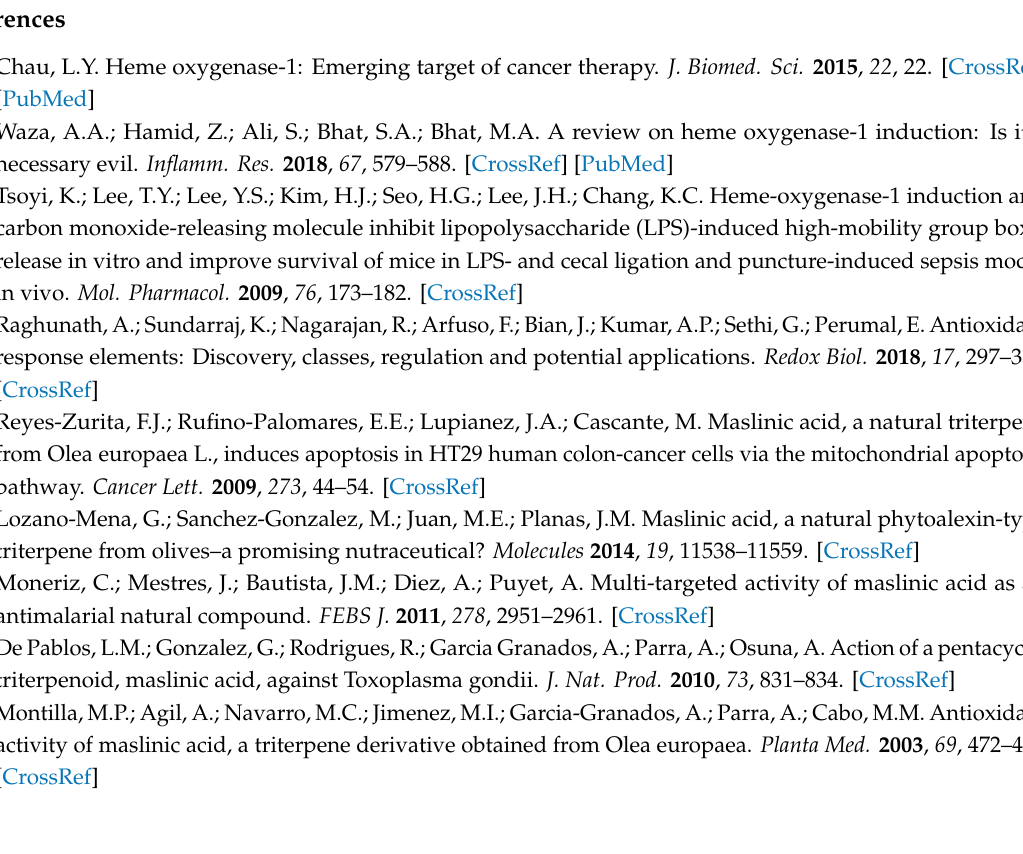
Figure S1: Uncropped pictures of the Western blot shown in Figure 1B; Figure S2: Uncropped pictures of the Western blot shown in Figure 3A (Upper); Figure S3: Uncropped pictures of the Western blot shown in Figure 3A